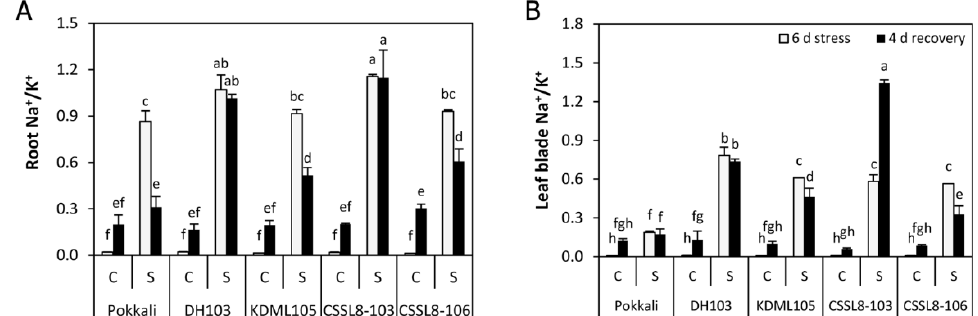
Figure 7. Na + /K + ratio in ( A ) roots and ( B ) leaves of rice plants under control and salt stress for 6 days (light gray bars) and after recovery for 4 days (black bars). C, control; S, salt stress. For a description of the genotypes, see Figure 1. Values are means of four replications ± SE. Different letters indicate a significant difference in the means of each group ( p ≤ 0.05).